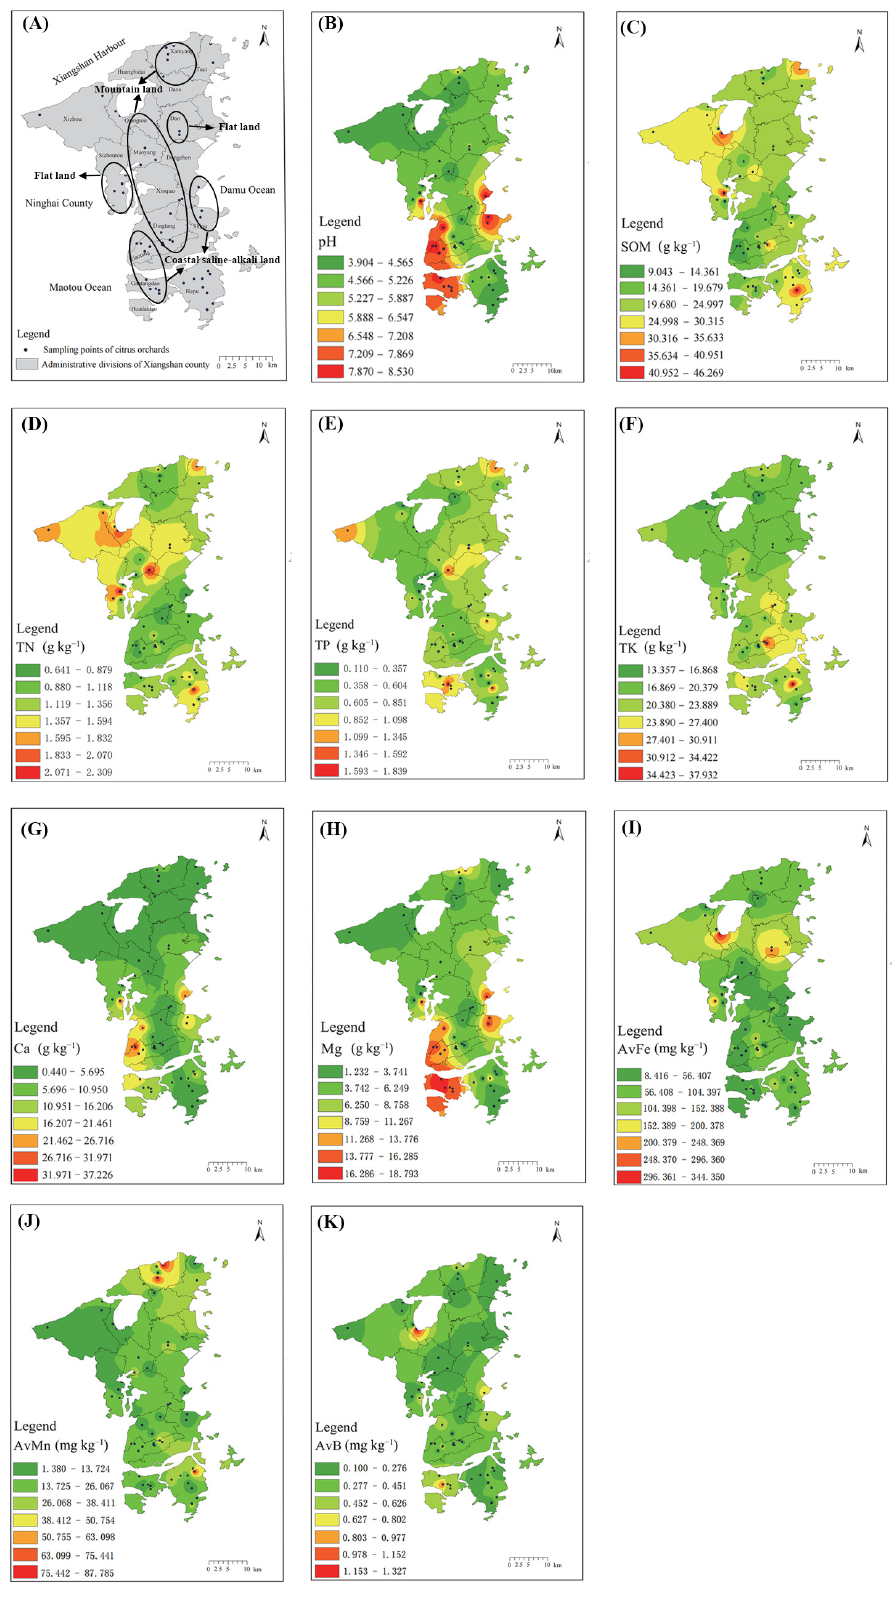
Figure 1. ( A ) Sampling points of citrus orchards in Xiangshan county. Spatial distribution of soil pH ( B ), soil organic matter (SOM) ( C ), the content of total N (TN) ( D ), total P (TP) ( E ), total K (TK) ( F ), total Ca ( G ), total Mg ( H ), available Fe (AvFe) ( I ), available Mn (AvMn) ( J ), available B (AvB) ( K ).